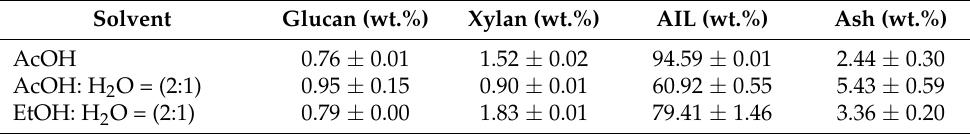
Table 3. Compositional analysis of the extractive when using three solvents. Solvent Glucan (wt.%) Xylan (wt.%)